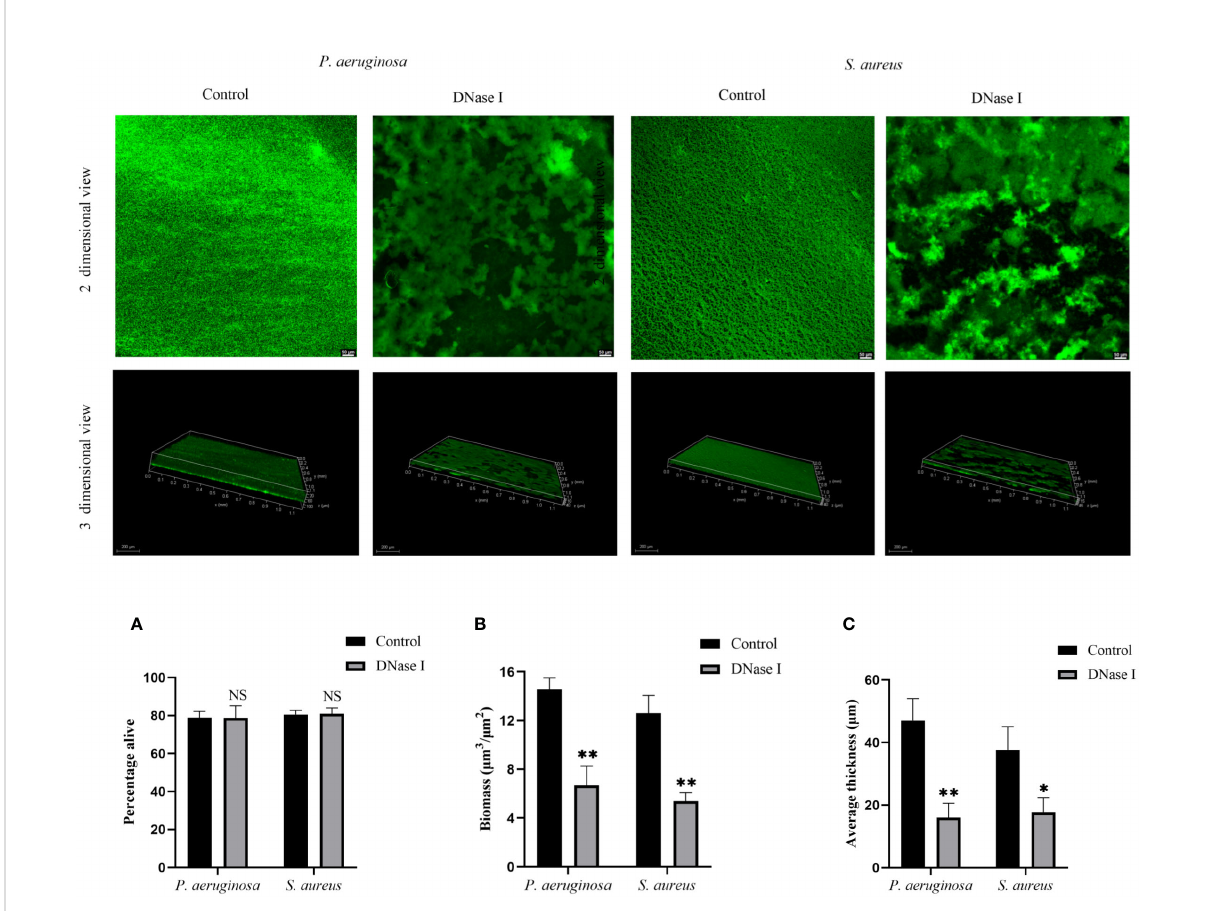
FIGURE 6 Analysis of DNase I effect on the P. aeruginosa and S. aureus bio fi lm structures. CLSM analysis of the bio fi lms formed in the presence or absence of DNase I. The bi-dimensional and three-dimensional bio fi lm structures were obtained using the LIVE/DEAD ® Bio fi lm Viability Kit. Viable bacteria cells with intact membranes are stained fl uorescent green. (A) Represents the percentage of live cells. (B) The bio fi lm biomass of CLSM analysis. (C) Mean thickness of bio fi lm using CLSM analysis. The data are presented as mean ± SD. An asterisk indicates a signi fi cant difference; * indicates p < 0.05, ** indicates p < 0.01, and NS indicates p- values > 0.05, compared with the values in the drug-free control group using t -tests (n =